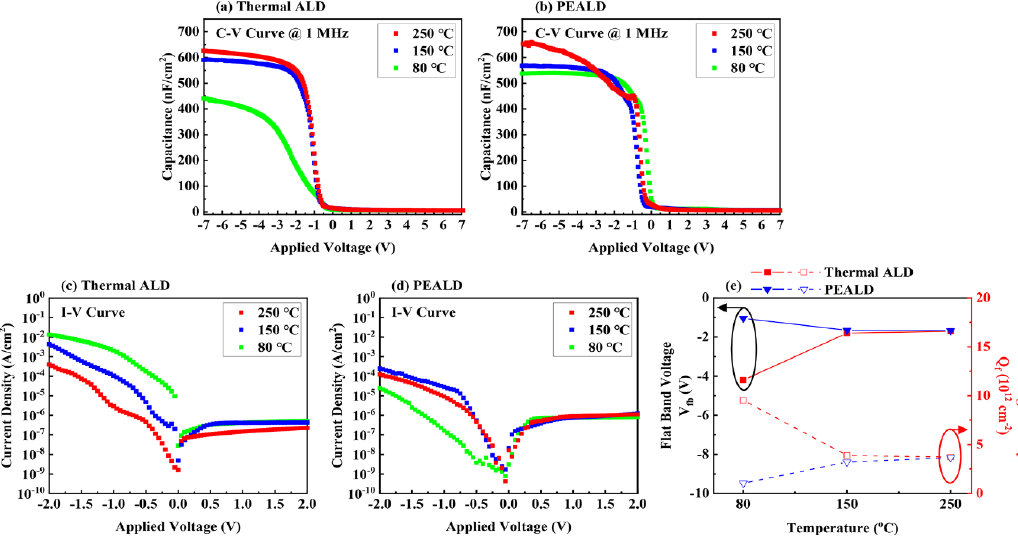
Figure 5. ( a , b ) C – V and ( c , d ) I – V curves of HfO 2 (10 nm) MOS capacitors fabricated, using